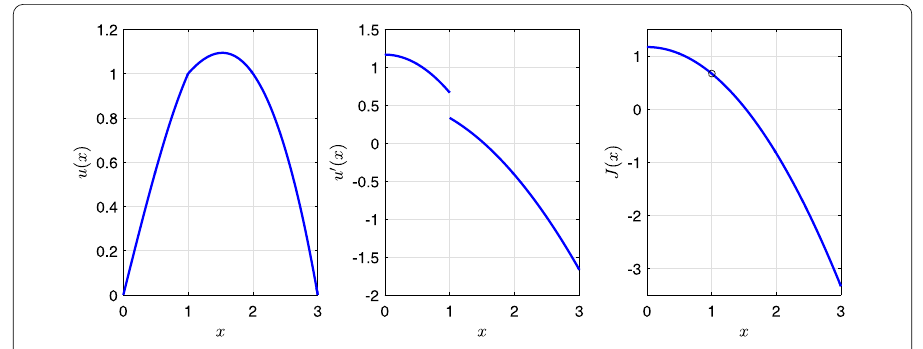
Figure 7 Verifying the solution of the example with piecewise constant κ ( x ) Process of removing the discontinuity of J ( x ) = κ ( x ) u (cid:6) ( x